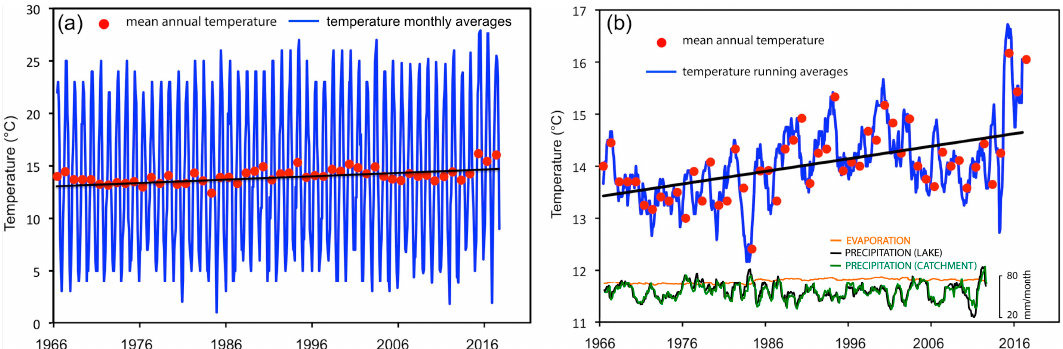
Figure 9. ( a ) Mean annual temperatures of lake water (red dots) and simple fit of the data (black lines) compared to the monthly average temperature of lake water from 1966 to 2018 (blue curve); ( b ) 12-month running averages (blue curve) of monthly temperature from 1966 to 2018, compared to mean annual temperatures of lake water (red dots) and simple fit of the data (black lines). Temperatures from April 2006 to January 2015 are from this study; data from July 1966 to March 2006 are taken from Ludovisi and Gaino [5]; data from July 2015 to January 2018 are from ARPA-Umbria [35]. At the bottom of Figure 9b, the 12-month running averages of monthly evaporation, precipitation on the lake and precipitation on the basin from 1966 to 2013 are shown.